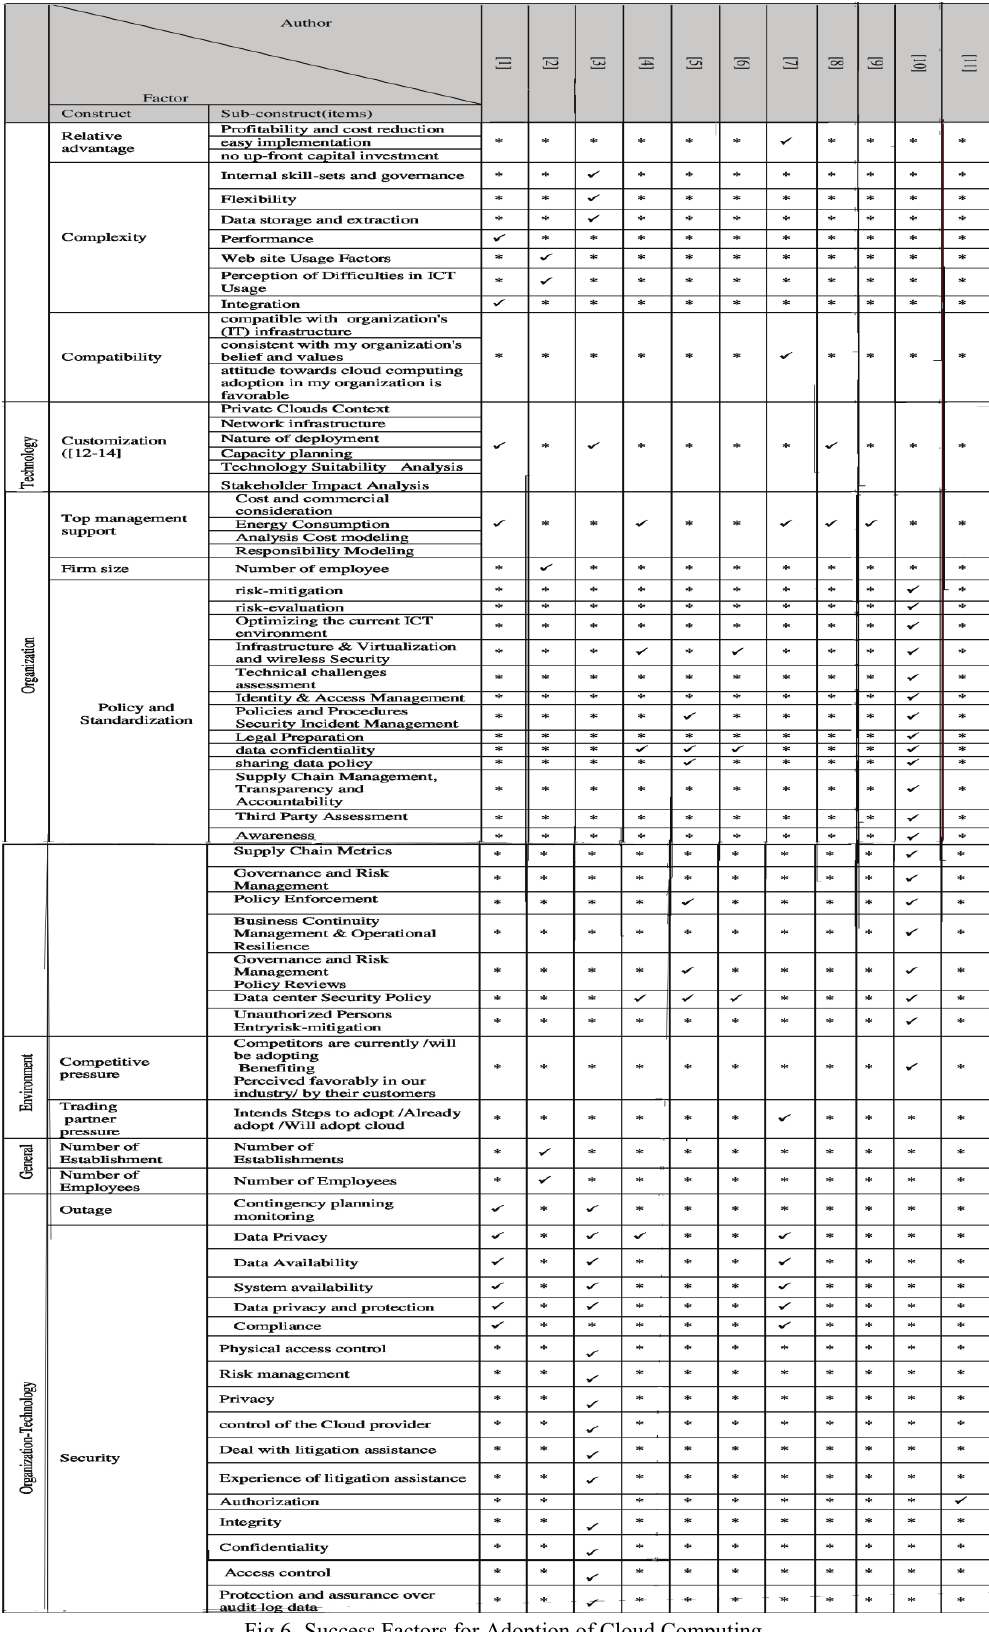
Success Factors for Adoption of Cloud Fig.6 .